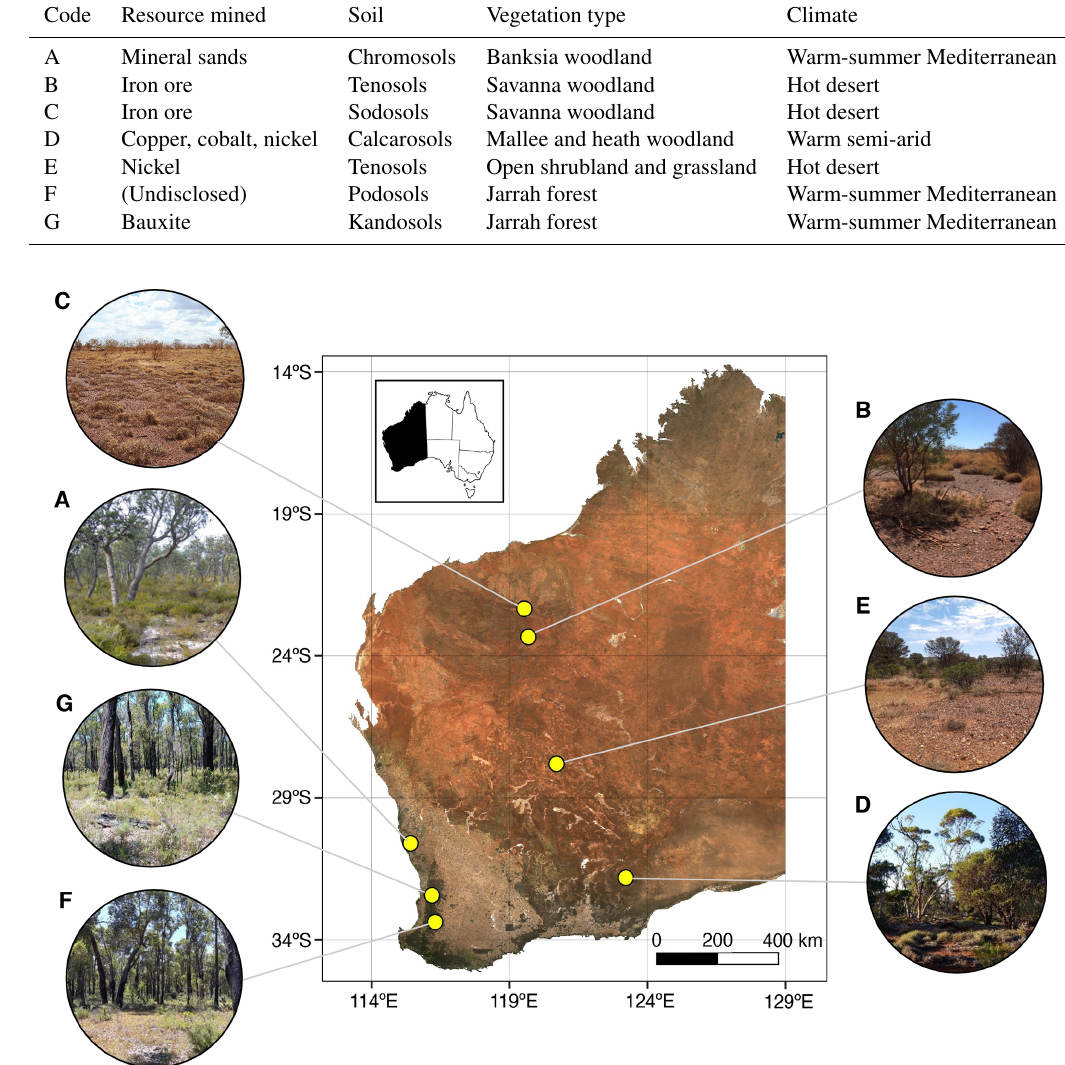
Table 1. Resource type mined, predominant soil type, dominant vegetation type, and climate type for each of the mine sites included in the study. Note that Mine F has requested non-disclosure of resource mined.